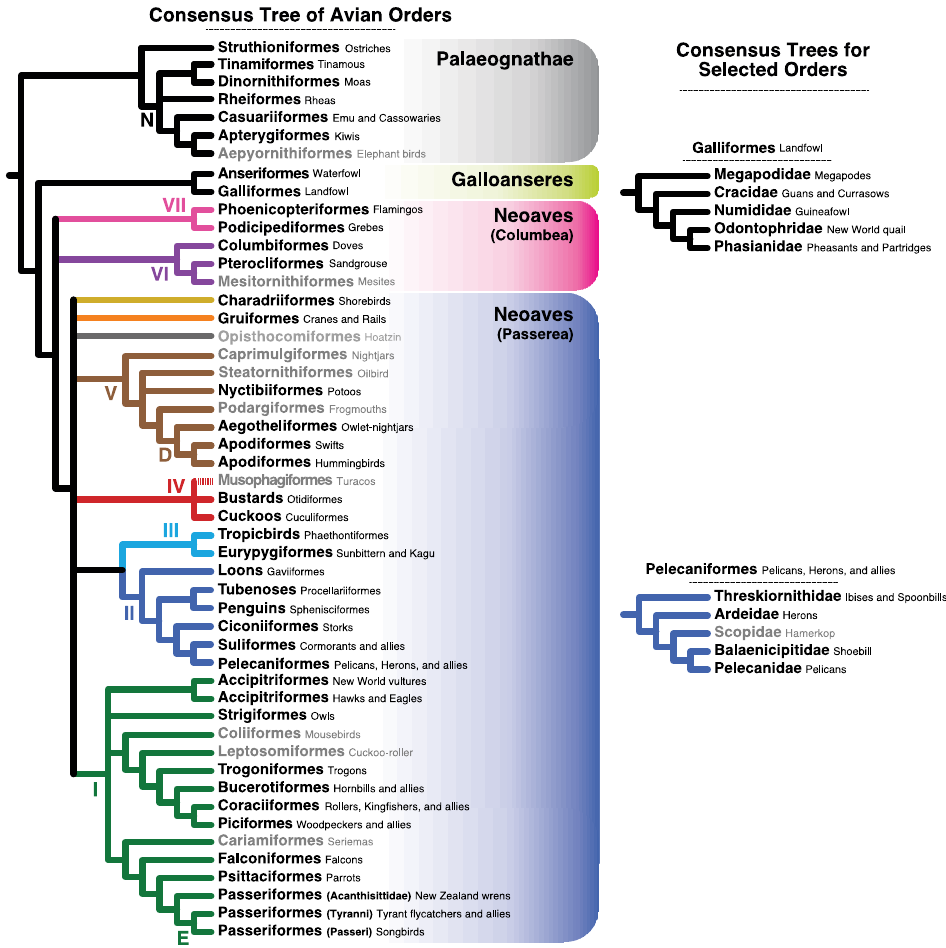
Figure 1. Consensus phylogeny of birds based on phylogenomic data. This cladogram reflects a recent phylogenomic supertree analysis [52] modified based on the results of two more recent phylogenomic studies [14,53]; relationships that are highly uncertain are presented as polytomies. Most terminal taxa correspond to orders as defined in the IOC World Bird List v. 6.1, with the exception of the IOC Caprimulgiformes (clade V) where we used the ordinal definitions of Chen et al. [54,55]. These ordinal definitions are strongly corroborated so we view their monophyly as “known.” Roman numerals indicate the “magnificent seven” superordinal clades defined by Reddy et al. [10]; the historical signal uniting the magnificent seven is weak, but they are relatively well corroborated. The dashed line highlights an exception; support for the position of Musophagiformes is especially weak [14], this is not relevant to the present study given our taxon sample. Three additional clades are indicated using letters: “N” (within Palaeognathae) indicates Notopalaeognathae (non-ostrich paleognaths [56]); “D” (within clade V) indicates Daedalornithes (owlet-nightjars, swifts, and hummingbirds [57]); and “E” (within Passeriformes) indicates Eupasseres (all passerines except the New Zealand wrens [58]). Relationships within two selected orders are also shown; they were chosen because they highlight relationships where the positions of taxa in published mitochondrial phylogenies differed from the position in nuclear phylogenies [42,59,60]. Orders and families without a complete (or nearly complete) mitogenome sequence included in this analysis are presented in gray.